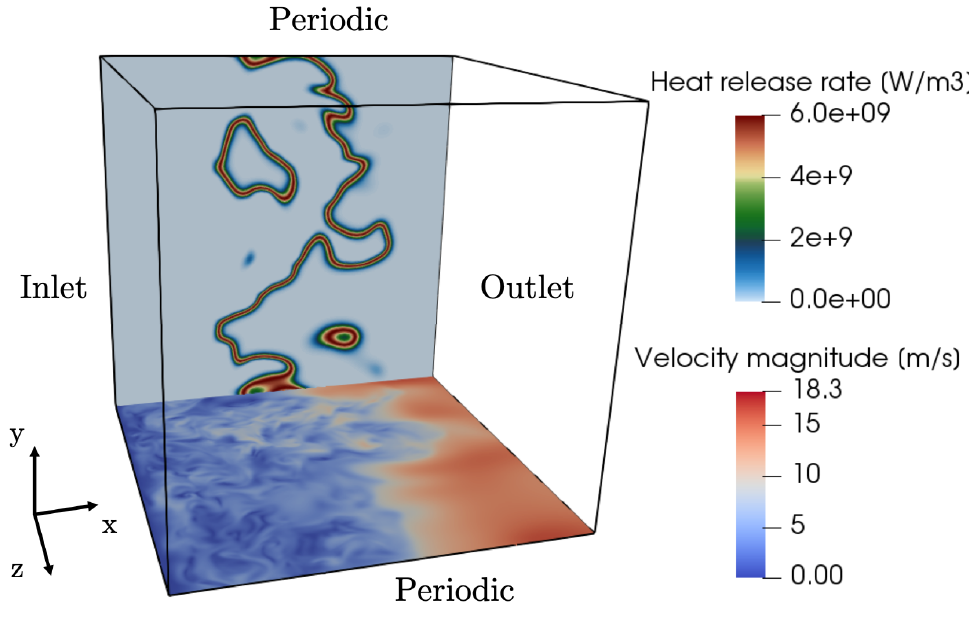
Figure 1. Slices of the HIT DNS at t = 2 τ : velocity magnitude in the xz -plane and heat release rate in the xy -plane.